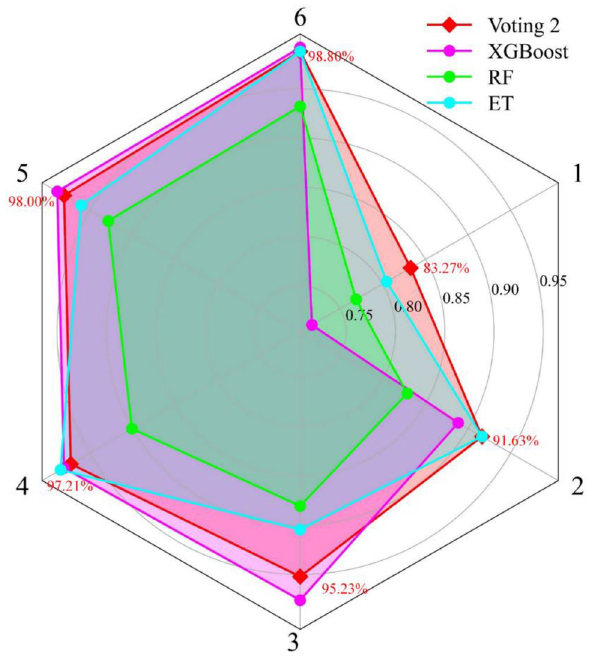
Figure 17. The accuracy in training set when adopting different input parameters.